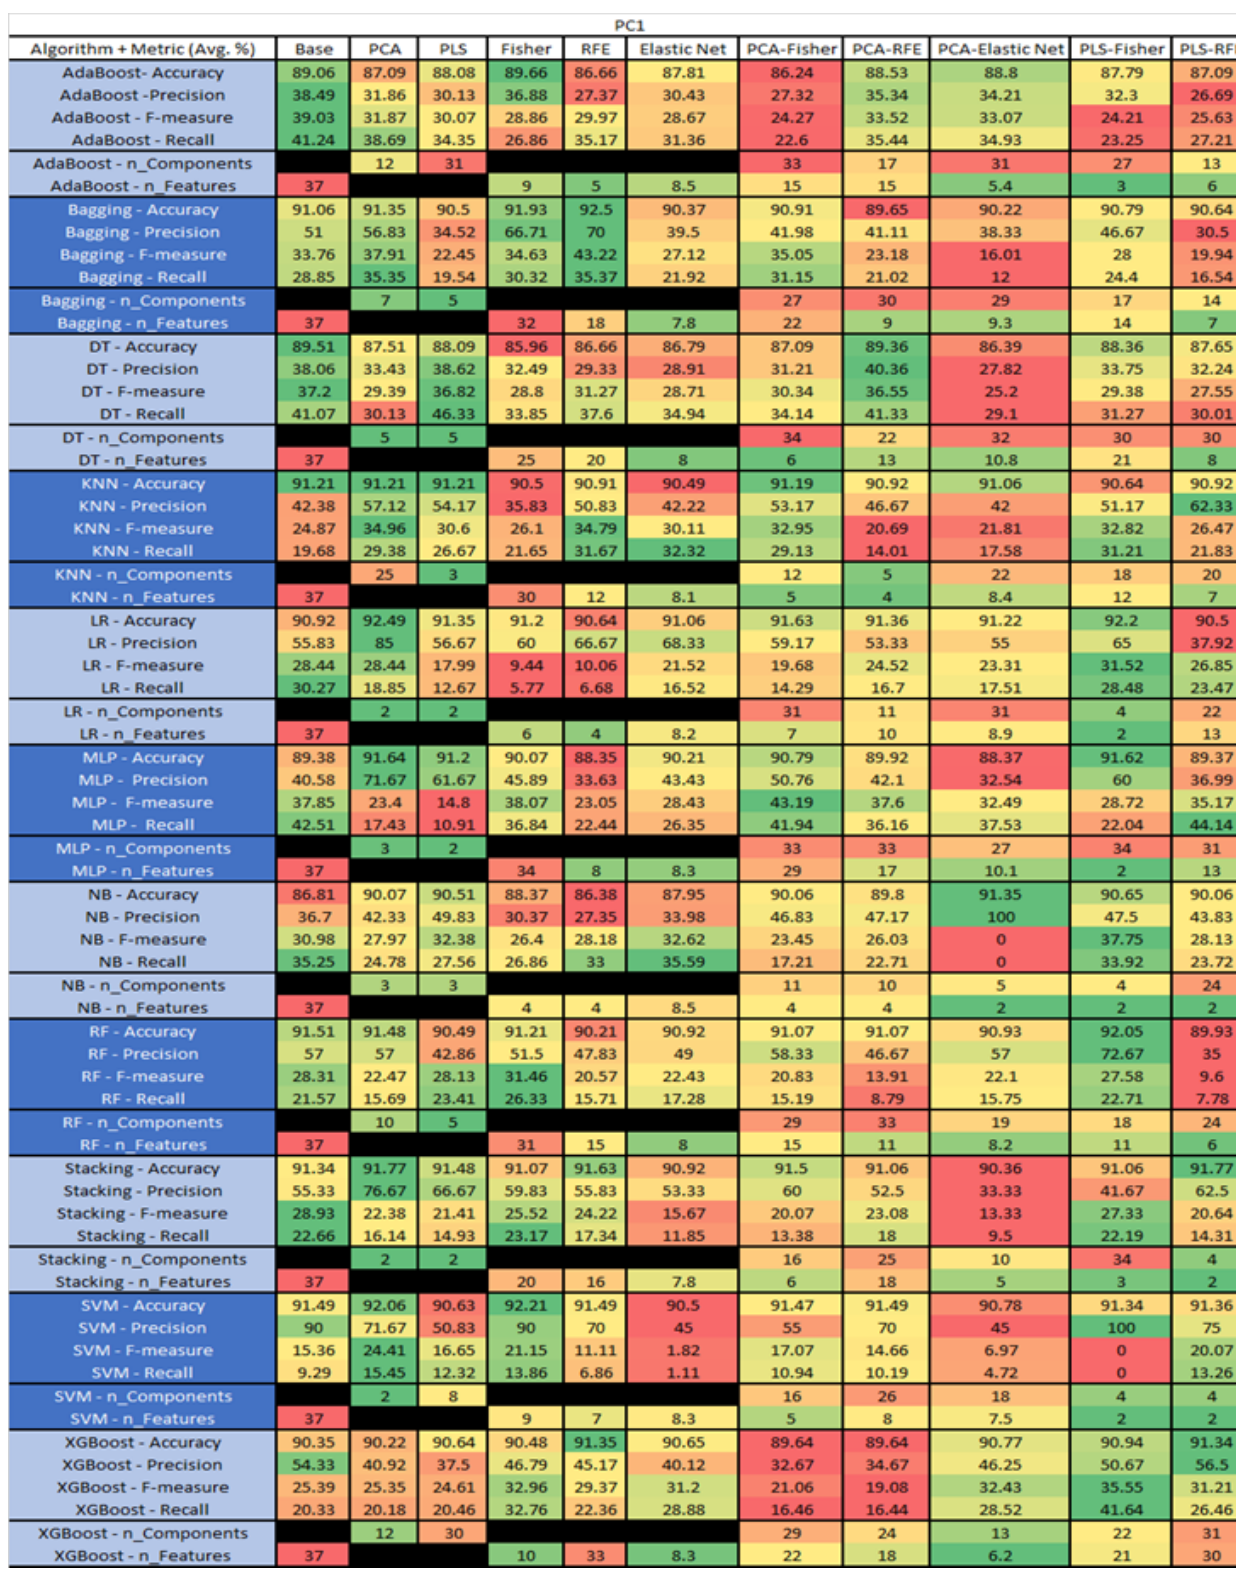
Figure 40. PC1 NASA MDP Results Data